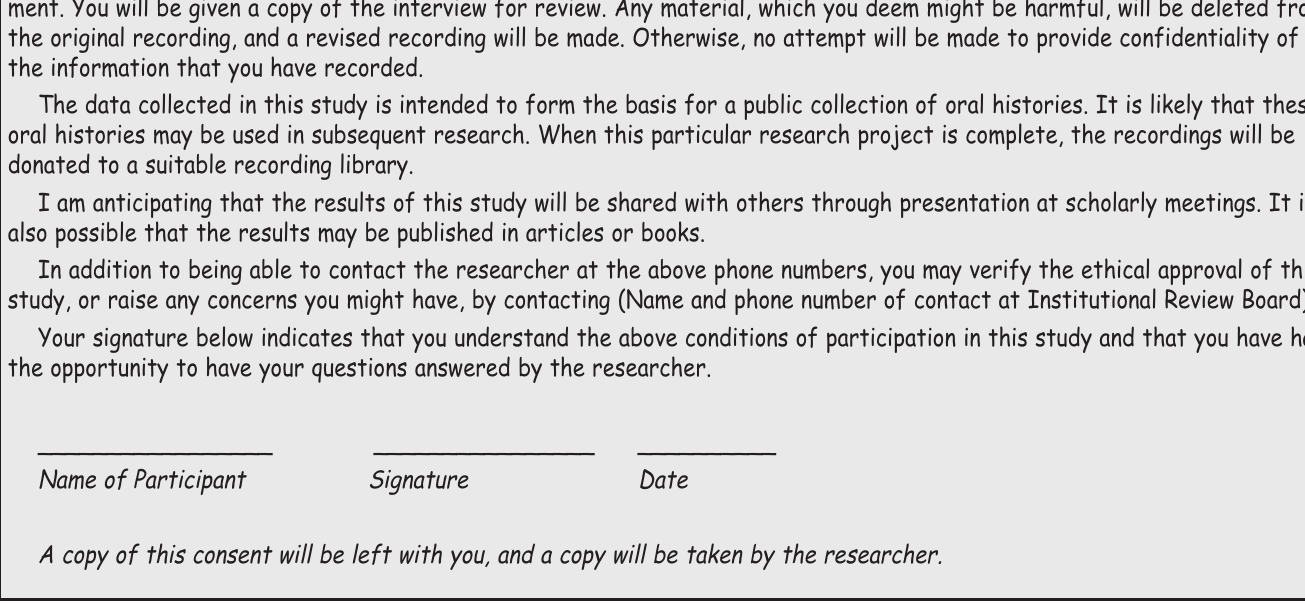
Figure 2. Example of Participant Consent